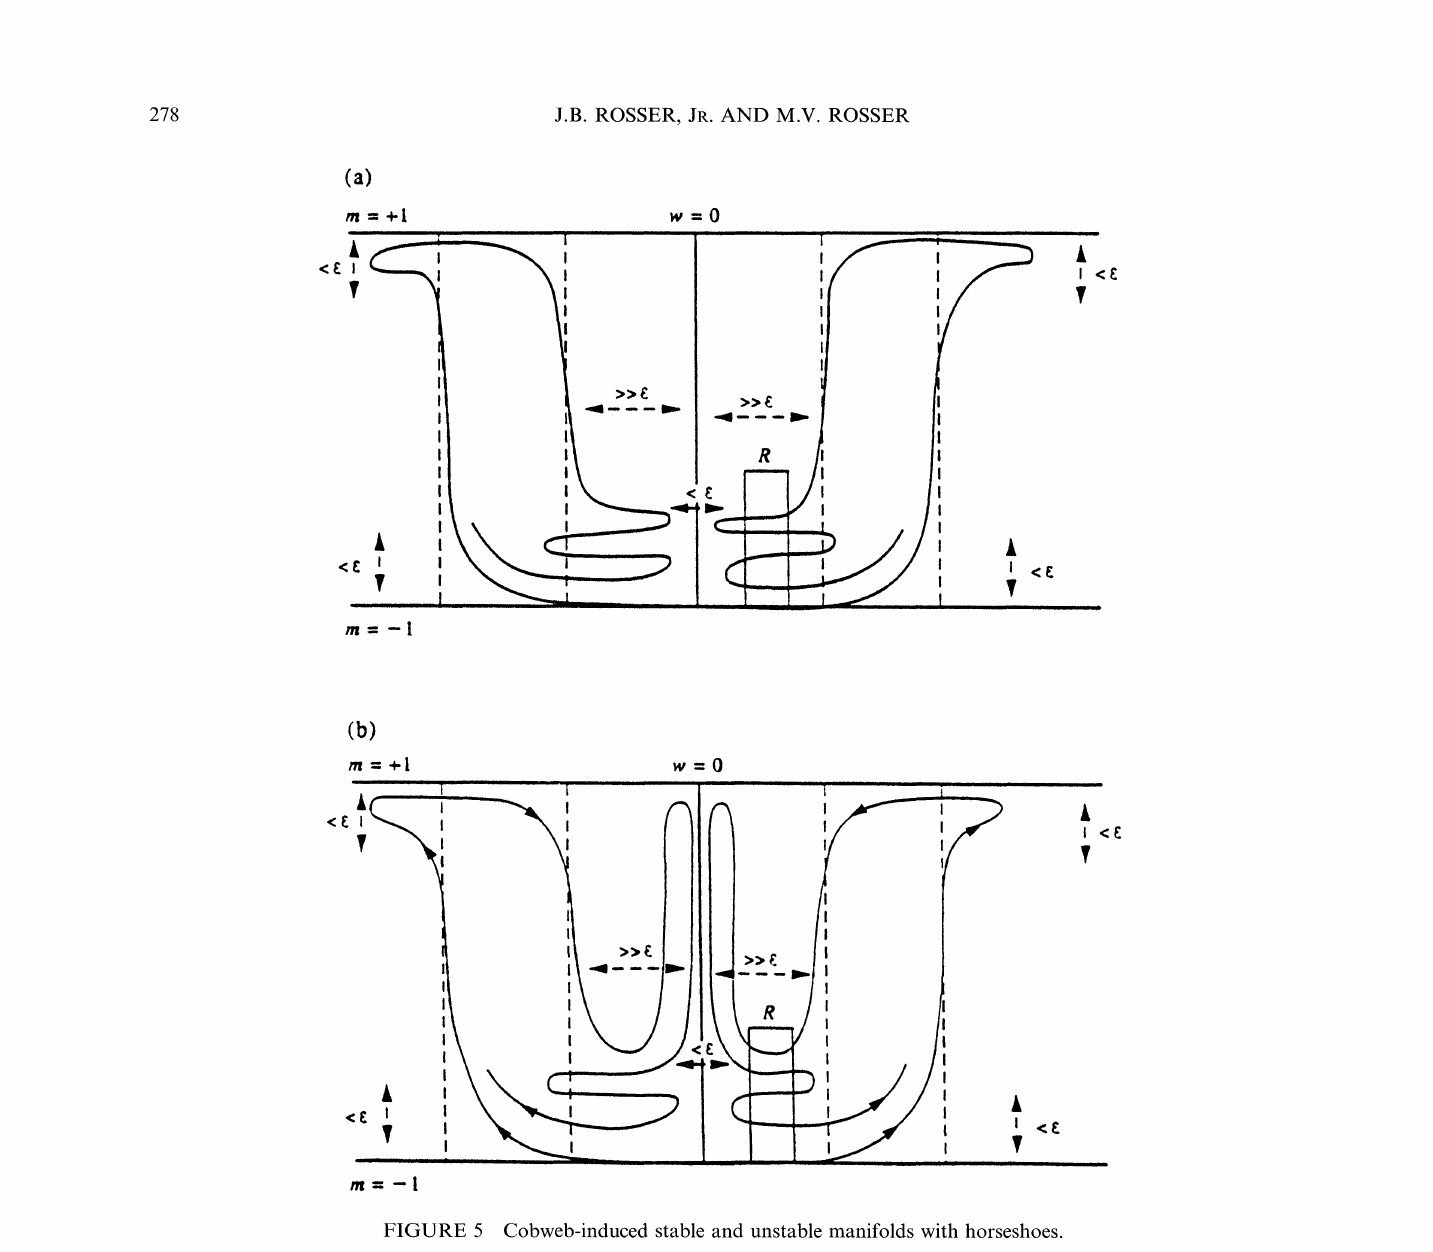
FIGURE 5 Cobweb-induced stable and unstable manifolds with